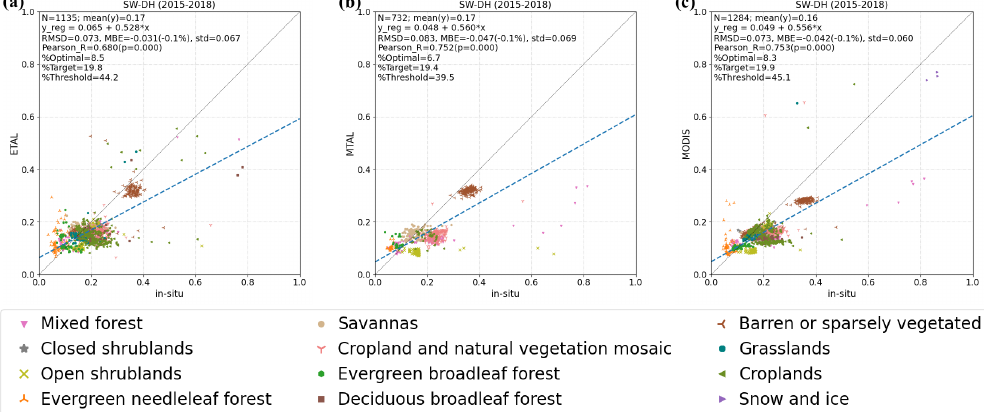
Figure A4. Accuracy assessment of ( a ) ETAL, ( b ) MTAL-R/NRT and ( c ) MODIS surface albedo satellite products versus ground measurements coming from GBOV, AMMA and BSRN stations during the 1 January 2015–31 December 2018 period. All data are included. The continuous black line corresponds to the 1:1 line. The blue dashed line corresponds to the regression